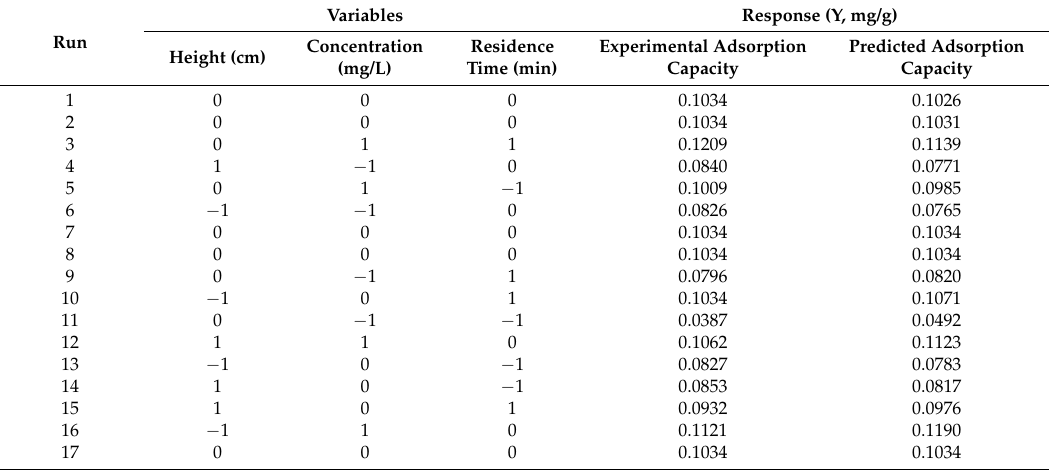
Table 7. The experimental design matrix and response based on the experimental runs by Box–Behnken Design (BBD).